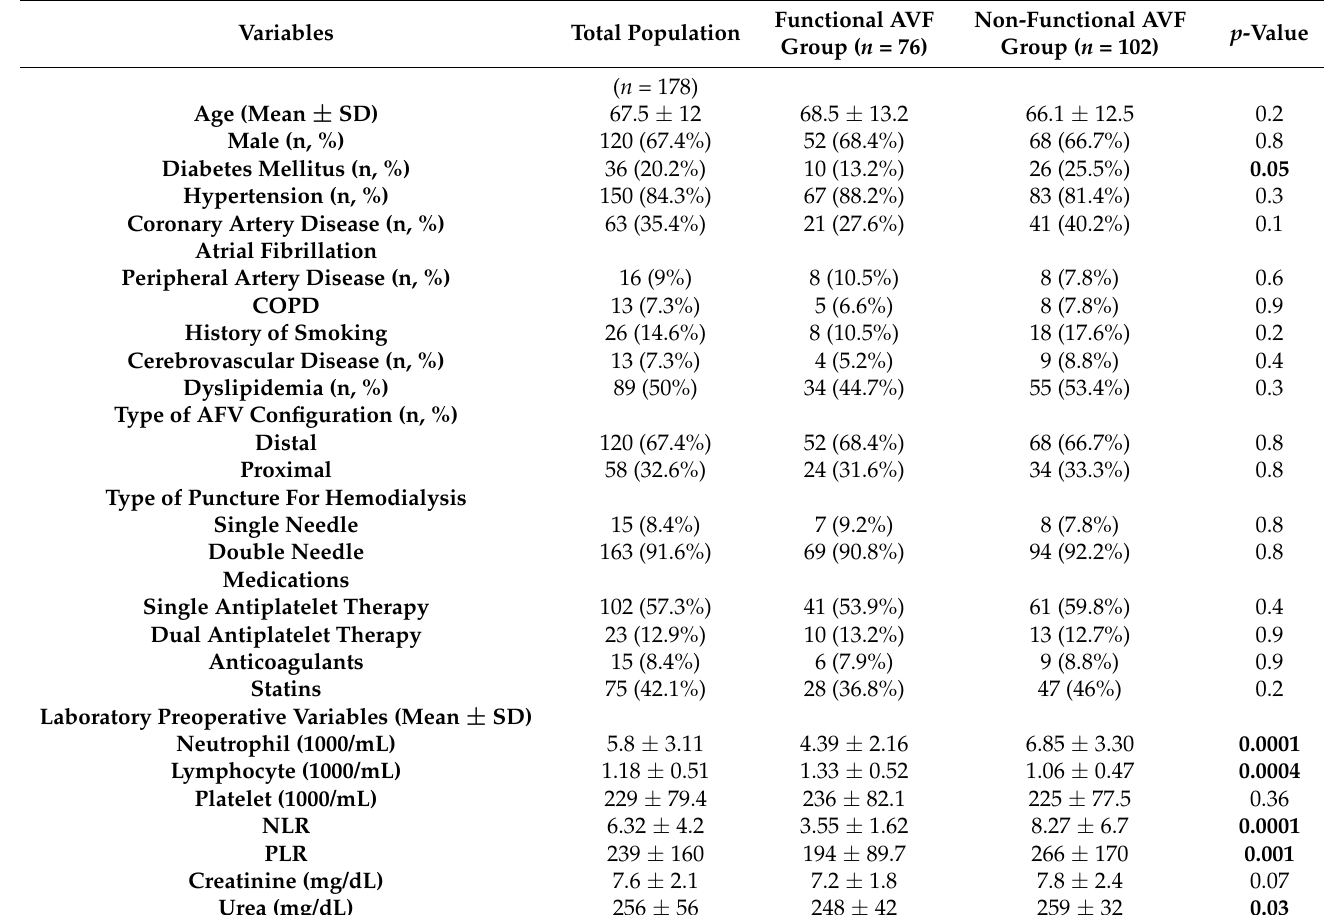
Table 1. Baseline characteristics of the population